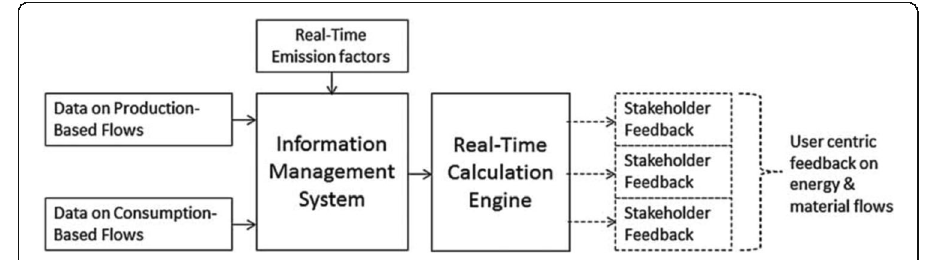
Fig. 3 Data flows for energy and materials in the SRS model. Source: Shahrokni et al. (2015b)